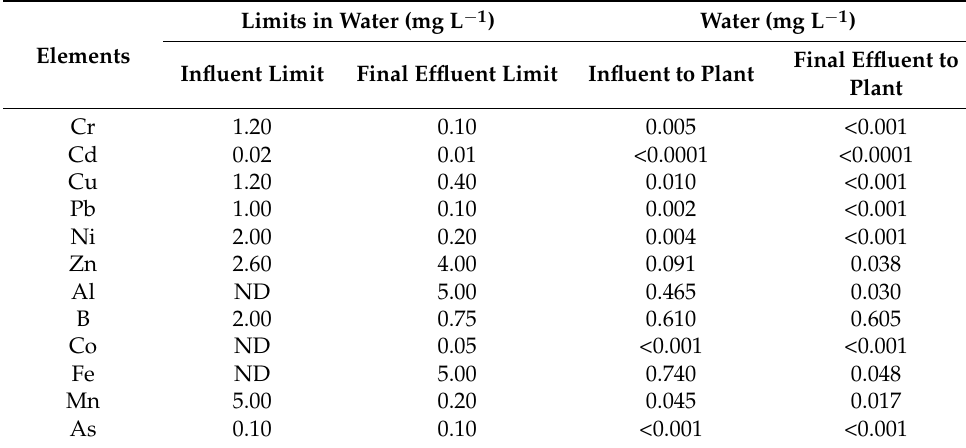
Figure 1. Macro (upper graph) and trace (lower graph) elements of soil prior to sowing for the old cultivated soil and virgin soil at different depths from the topsoil. Table 2. Global influent and effluent guidelines parameters limits for wastewater and analysis of treated-waste water used in the irrigation of bioenergy crops during the current